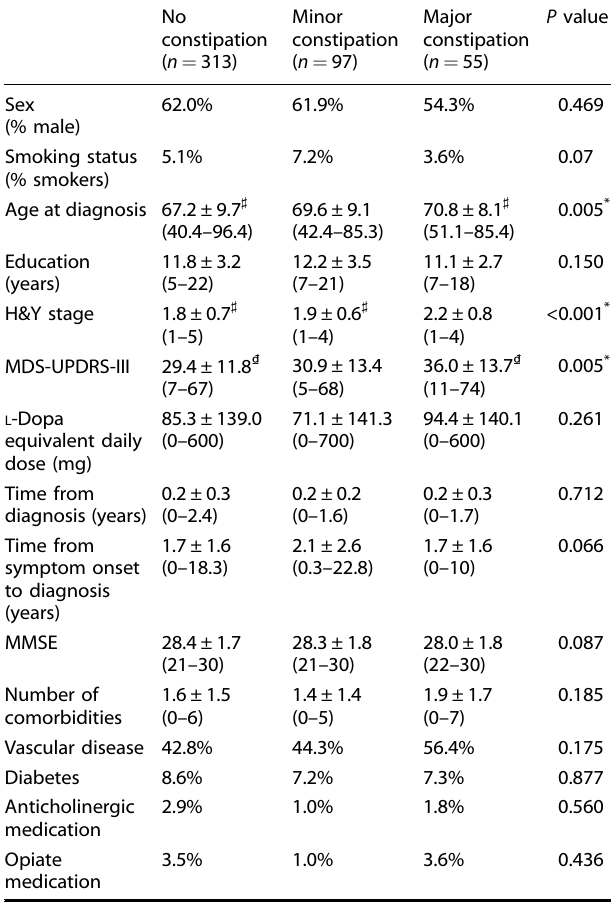
Table 1. Baseline demographic and clinical characteristics of PD patient groups strati fi ed by constipation